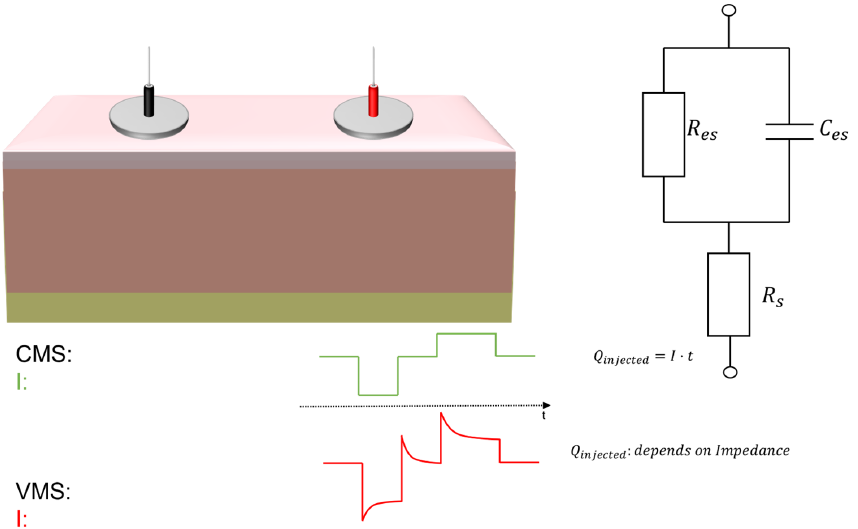
Figure 1. Equivalent skin-electrodes model. The contact between the electrodes and the skin can be modeled using a parallel circuit composed of a resistor R e s and a capacitor C es in series with a resistor R s . In VMS, the current profile is affected by the charge and discharge of the capacitor C es , leading to an uncertainty on the total delivered charge. In CMS, the charge delivered depends only on the shape of the current profile, e.g., using a rectangular profile, the delivered charge is given by the product between the current and the duration of the stimulation.